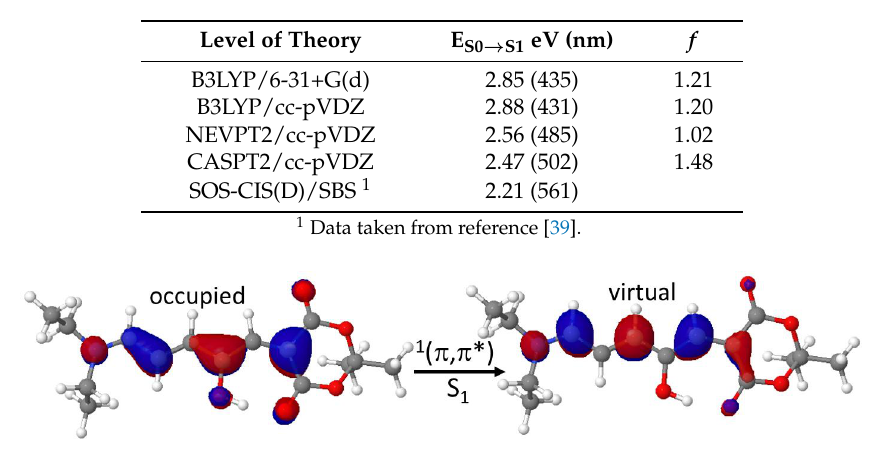
Figure 2. The occupied and virtual orbitals describing the electronic transition to the first excited state.